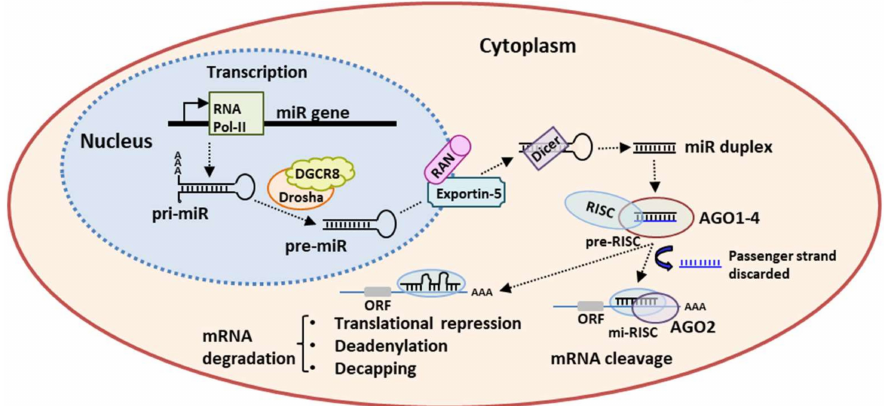
Figure 1. miRs processing and mechanism of action. RNA polymerase II (Pol-II) transcribes the primary miR transcript (pri-miR) subsequently cleaved by Drosha-DGCR8 complex into pre-miR. The resulting pre-miR is exported from the nucleus to the cytoplasm by Exportin-5 / Ran-GTP. RNase Dicer cleaves the pre-miR to its mature miR duplex that is loaded onto Argonaute (AGO1–4) proteins and forms the pre-e ff ector RNA-induced silencing complex (pre-RISC). The guide strand is retained into the mature miR-induced RISC (mi-RISC) whereas the passenger strand (blue) is discarded. A full complementary base pairing induces the mRNA cleavage by AGO2 slicing activity, while a partial complementary induces translational repression, deadenylation, and decapping followed by mRNA target